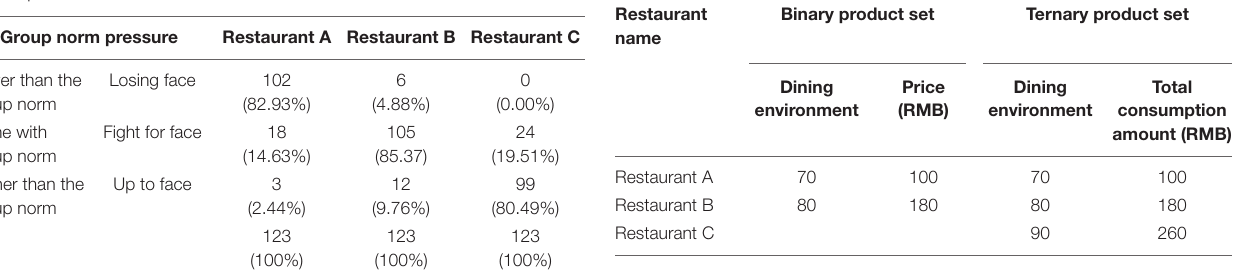
TABLE 2 | Consumer’s perception of group norm pressure when the reference point is product B.